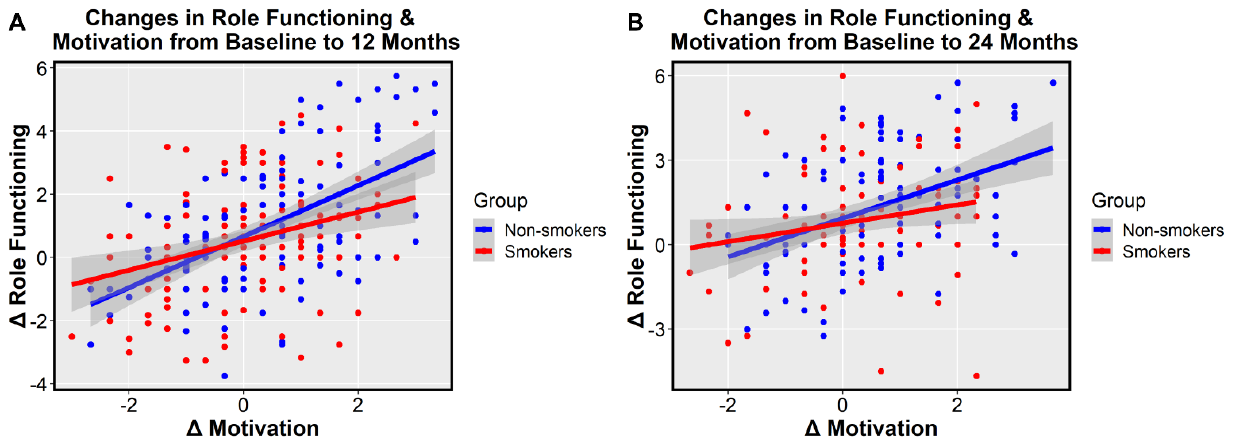
Figure 2. Relationships between change in motivation and change in Heinrichs-Carpenter Quality of Life Scale (QLS) role functioning by smoking status at baseline. ( A ) Change in motivation from baseline to 12-months predicts change in role functioning from baseline to 12-months. A significant main effect of change in motivation ( t = 7.25, p < 0.0001) and a significant group by change in motivation interaction ( t = −2.08, p < 0.039) are observed. A moderate correlation was observed for smokers ( r = 0.31, p < 0.0001) and a strong correlation was observed for non-smokers ( r = 0.55, p < 0.0001). ( B ) Change in motivation from baseline to 24-months predicts change in role functioning from baseline to 24-months. A significant main effect of change in motivation was observed ( t = 4.73, p < 0.0001). Smokers had a weak-to-moderate correlation ( r = 0.21, p = 0.042) and non-smokers had a moderate-to-strong correlation ( r = 0.43, p < 0.0001).